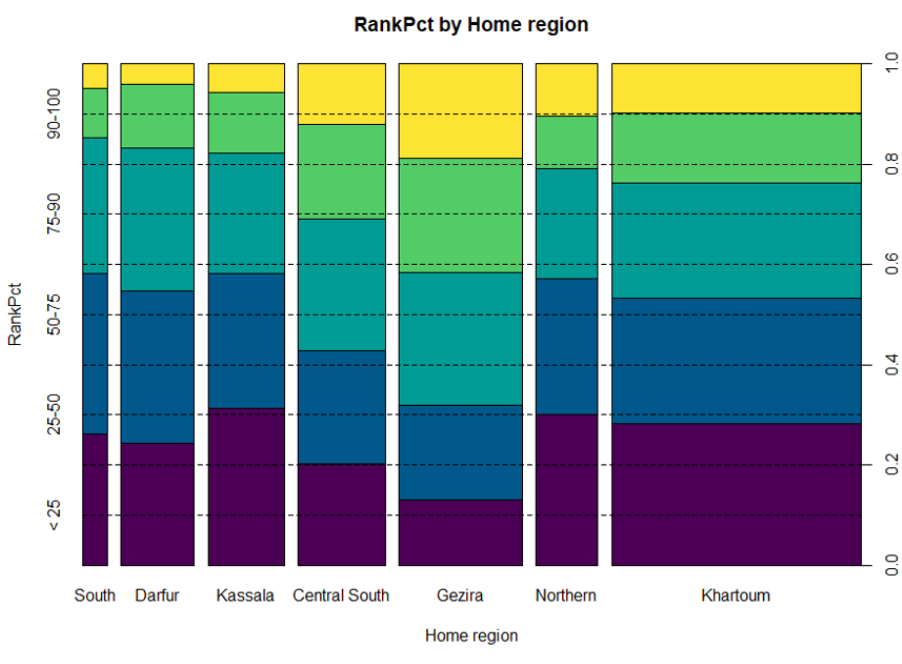
Figure 15. Academic rank by home region, incoming diploma students